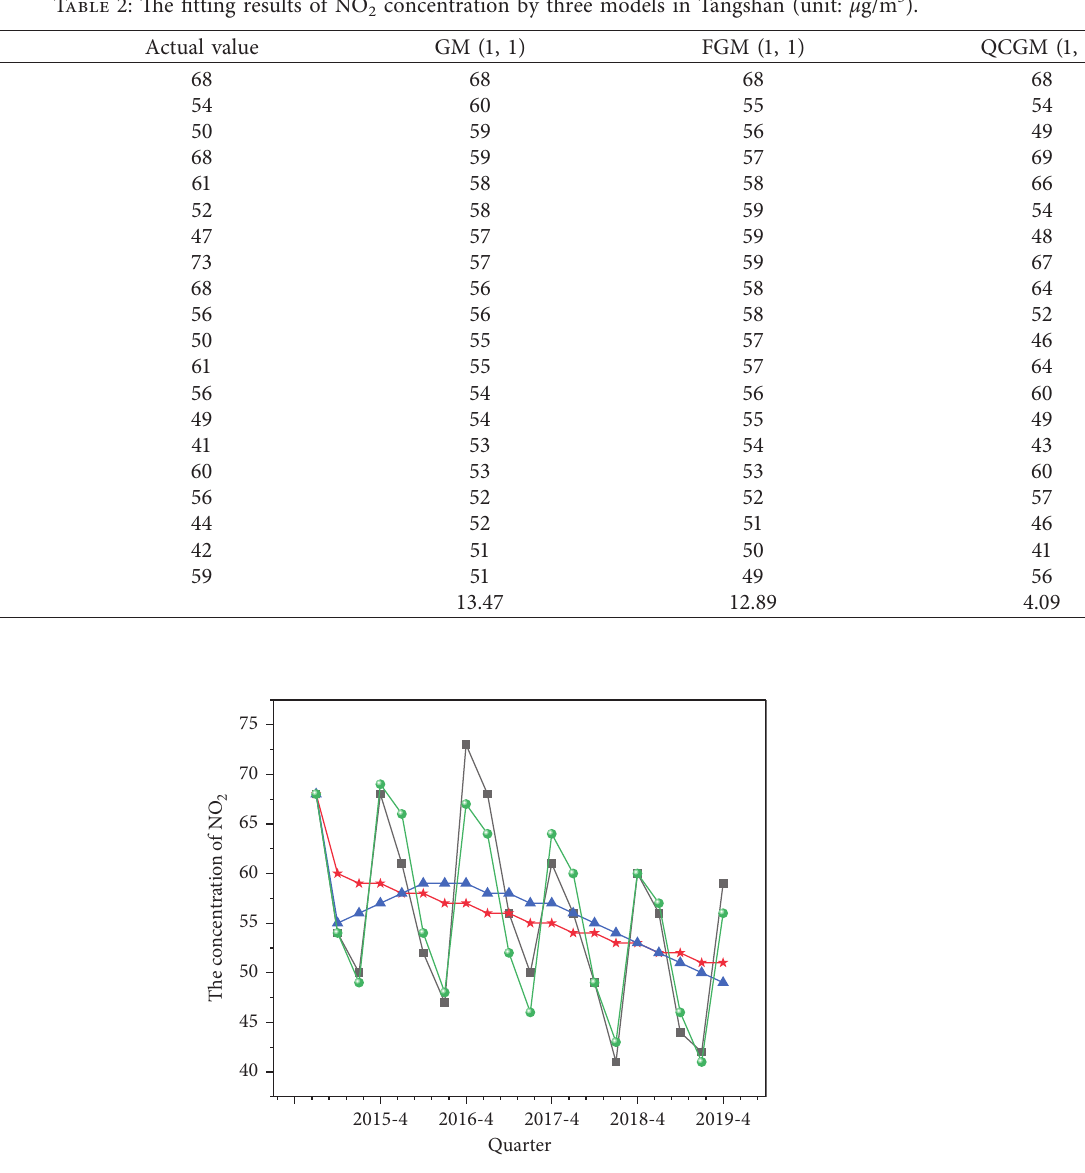
2 concentration by three models in Tangshan (unit: μ g/m